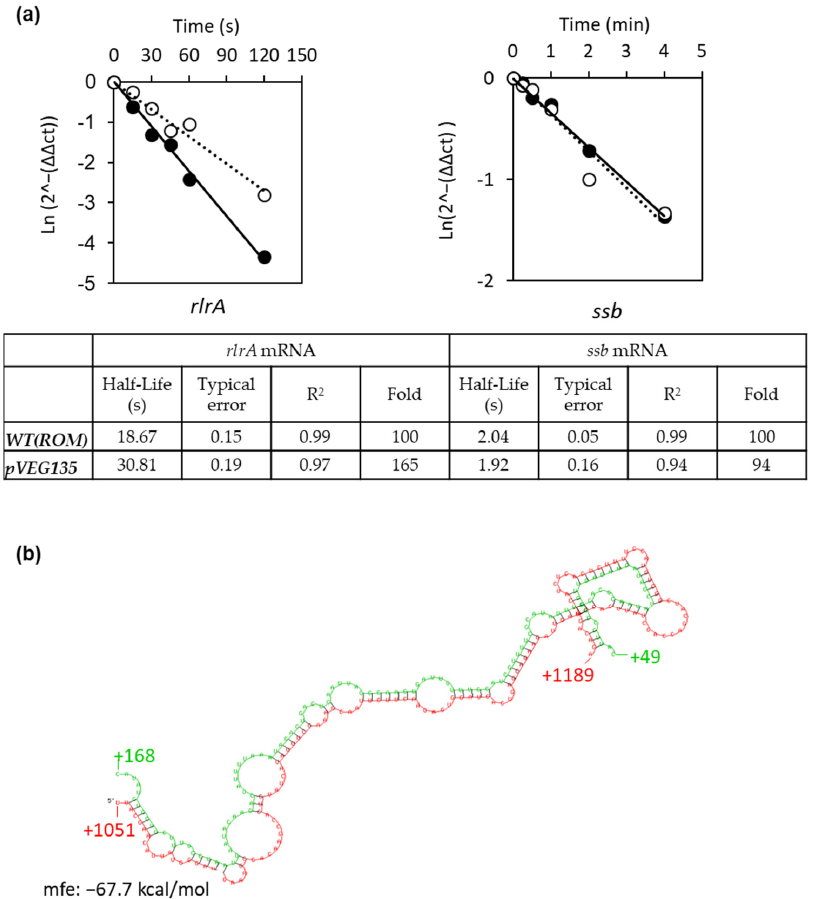
Figure 6. Overexpression of srn135 increases the stability of the rlrA mRNA. ( a ) Half-lives of rlrA (left panel) and ssb (right panel) mRNAs were measured in TIGR4(pROM) (black circle) and TIGR4(pveg135) (white circle) strains by quantitative RT-PCR. Bacterial samples were taken after the addition of rifampicin at the indicated times and RNA was extracted as described in Materials and Methods. Data are presented as the transcript levels relative to time 0 on each strain using the ∆∆ CT method over time. Half-lives were calculated from the slope of the regression curve. Experiments were performed in triplicate. Typical errors and R 2 of the regression line are shown. Half-lives of mRNAs in TIGR4(pROM) were arbitrarily reported as 100 and the values of TIGR4(pveg135) were relative. ( b ) Potential binding of rlrA mRNA (red) and srn135 (green) was analyzed with the RNA hybrid program using the web tool on the Bielefeld Bioinformatics Server (https://bibiserv.cebitec. uni-bielefeld.de/rnahybrid accessed on 27 July 2021). Graphical output of the energetically most favorable hybrid between both RNAs, with a minimum free energy (MFE) of − 67.7 kcal/mol